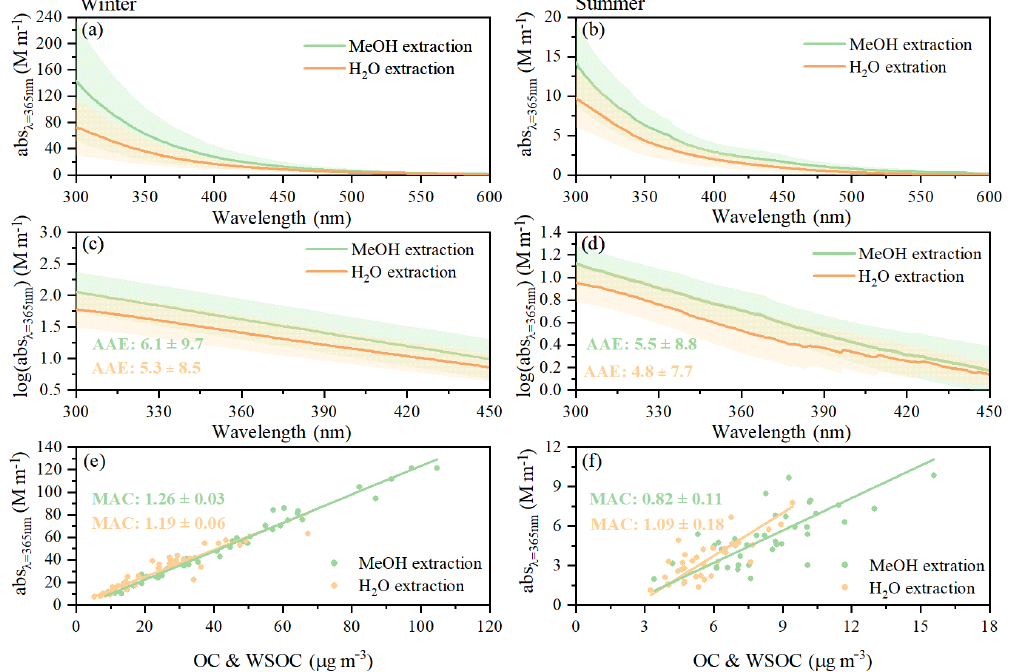
Figure 2. Seasonal average values of abs λ = 365nm , AAE and MAC extracted by MeOH and H 2 O. AAE is calculated by a linear regression